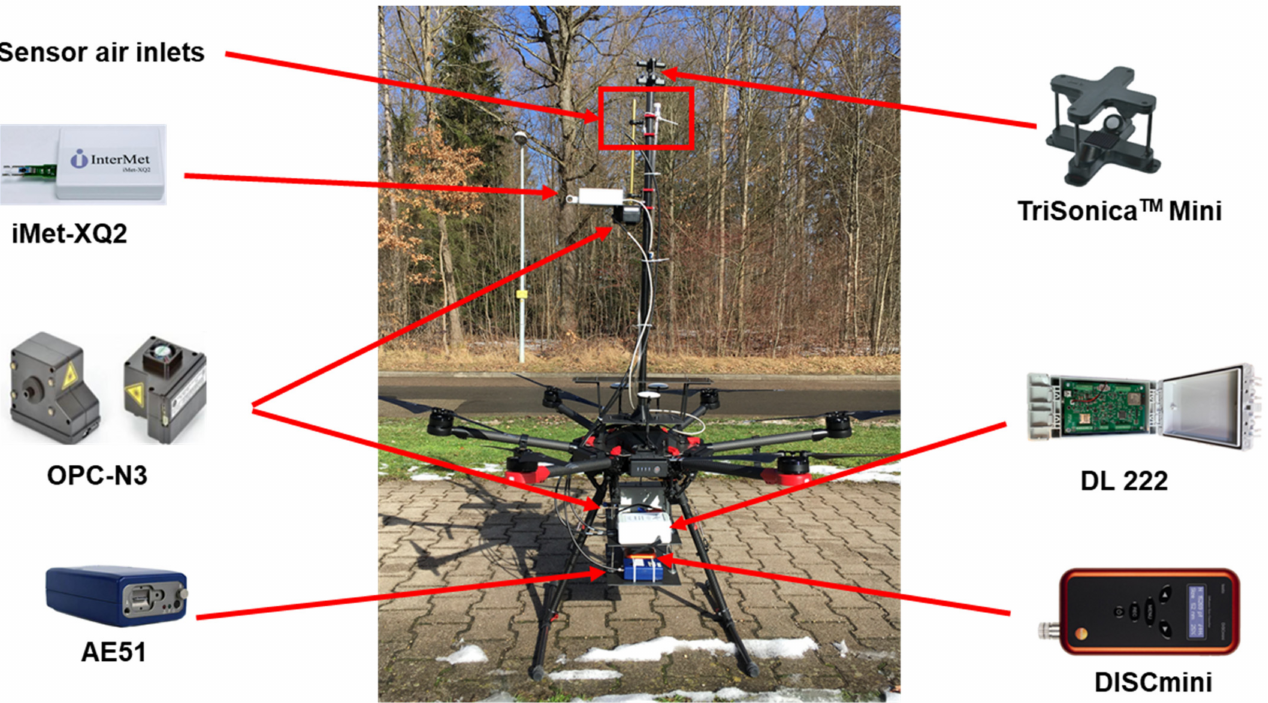
Figure 3. Configuration of the UAV